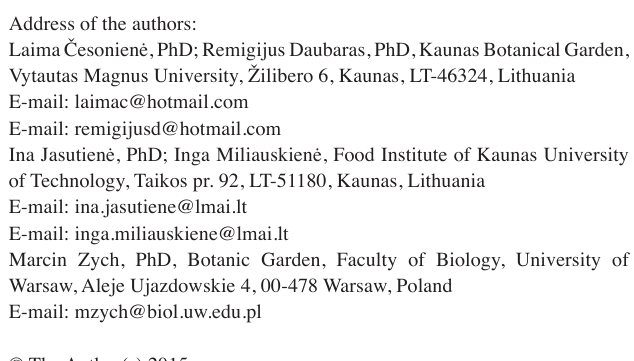
Hill.]. Studia Societatis Scientarum Torunensis Sectio D (Botanica) 11, 1-57 (in Polish).